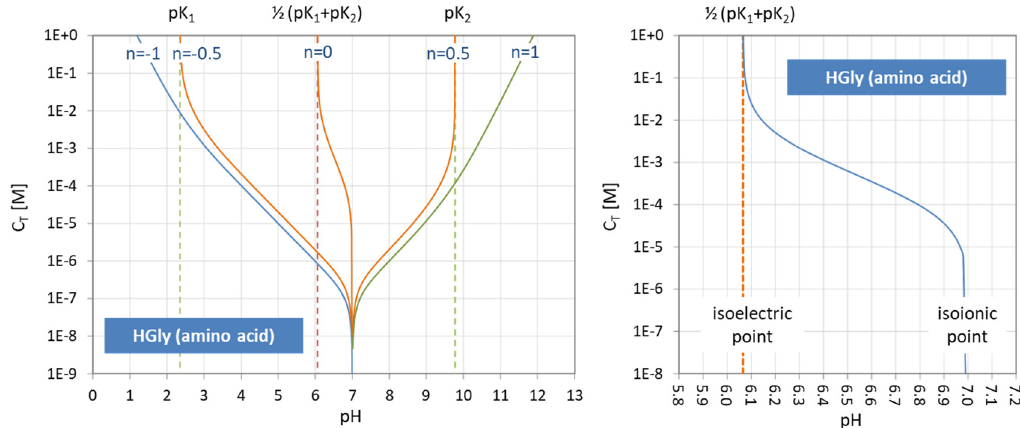
Figure 41. ( Left ) pH–C T diagrams for glycine. ( Right ): enlarged section around EP 0 showing the isoelectric and isoionic points as a function of C T .